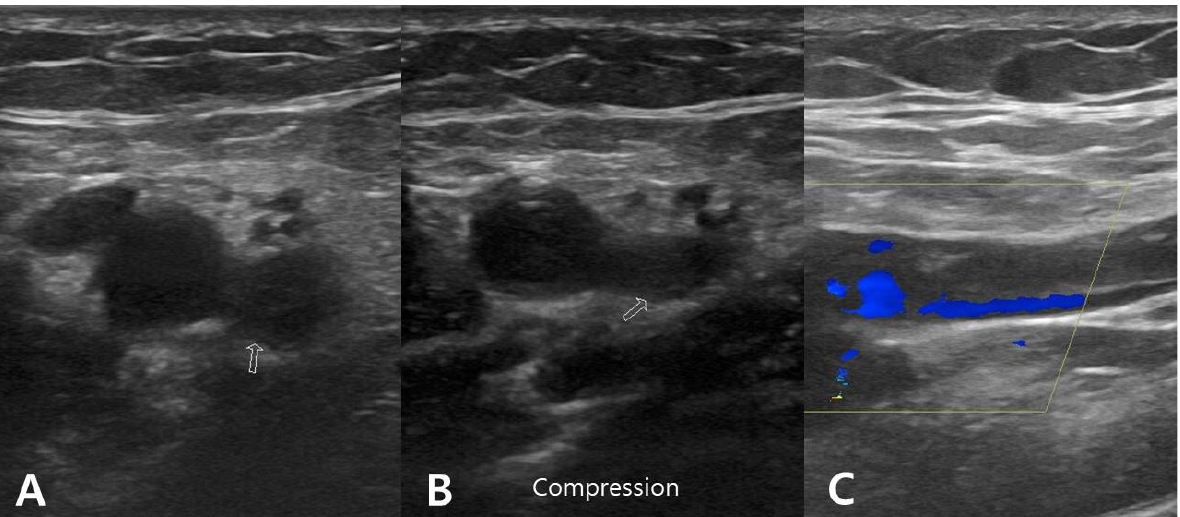
Figure 1. Duplex ultrasonographic image from a 76 year old man who underwent reverse total shoulder arthroplasty for proximal humerus fracture. ( A , B ) B-mode transverse image showing hypoechoic thrombus (arrow) in the brachial vein, which is not compressible by the probe. ( C ) Longitudinal color Doppler image revealing color filling defect in the brachial vein.